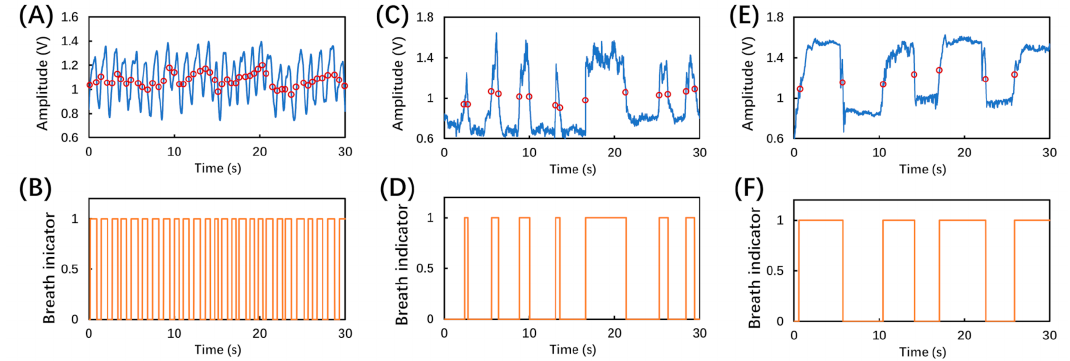
Figure 8. Experimentally recorded different breathing patterns and corresponding dynamic thresh- olds in real time for ( A ) fast breath, ( C ) irregular breath, and ( E ) deep breath; the output of breath analysis program using the dynamic thresholds corresponding to ( B ) fast breath, ( D ) irregular breath, and ( F ) deep breath